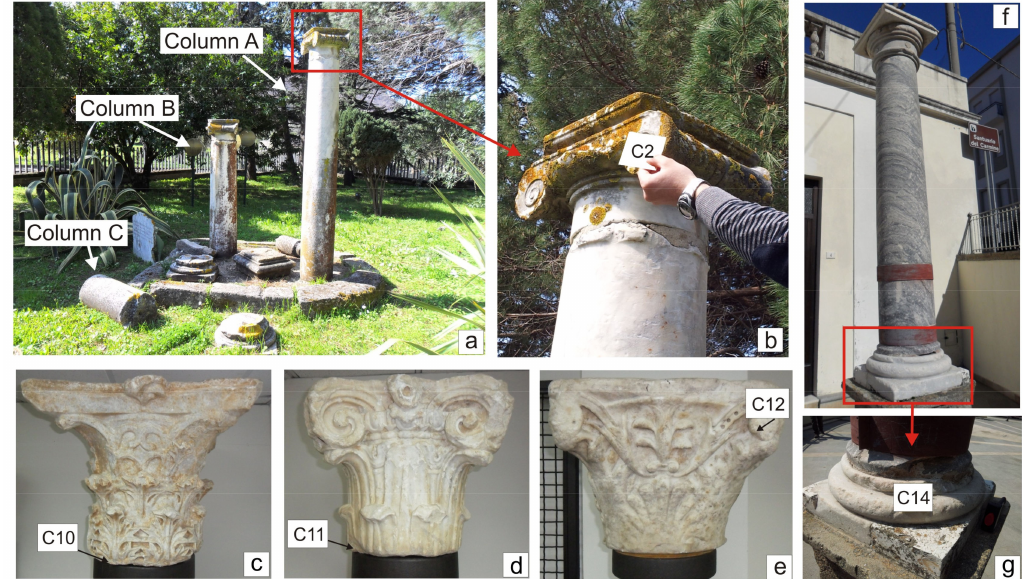
Figure 2. Some white marble samples taken from the architectural elements present in the local archaeological section of the Municipal Museum Complex ( a – e ) and from artifacts reused in the modern town ( f , g